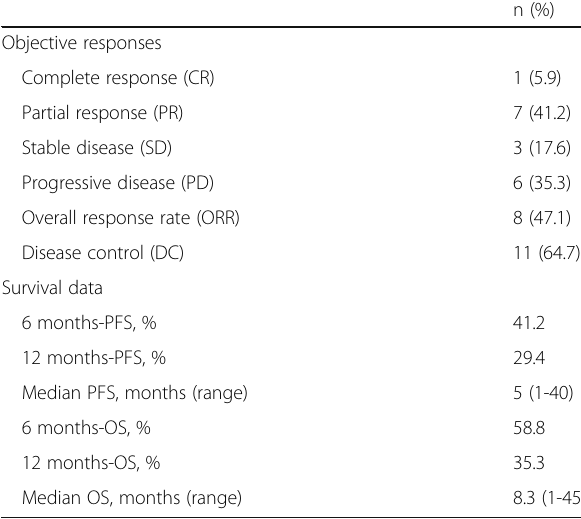
Table 2 Results obtained by using BEV in